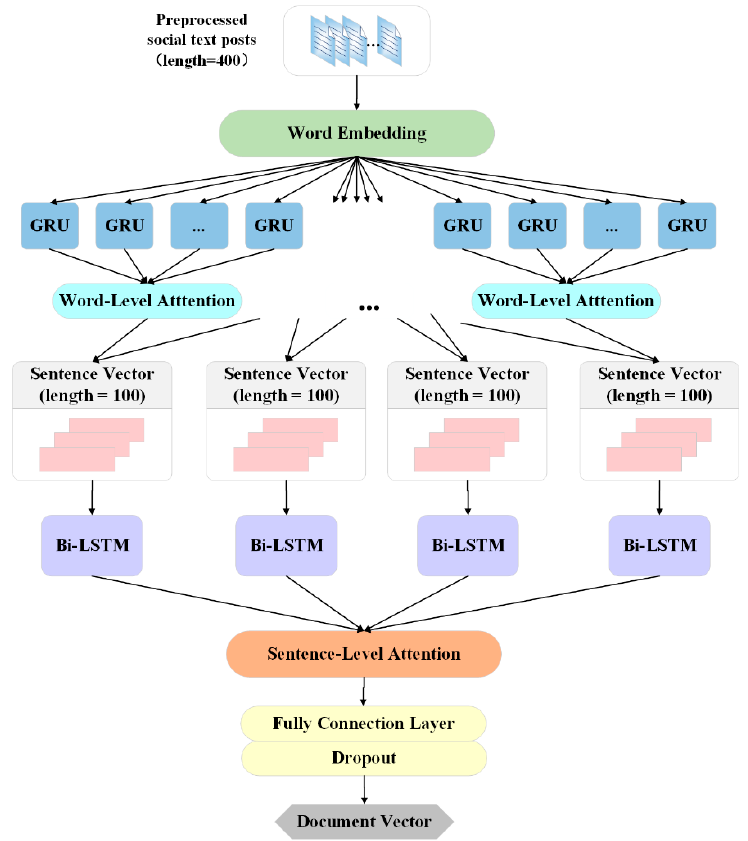
Figure 3. Architecture of HA-BiLSTM module.